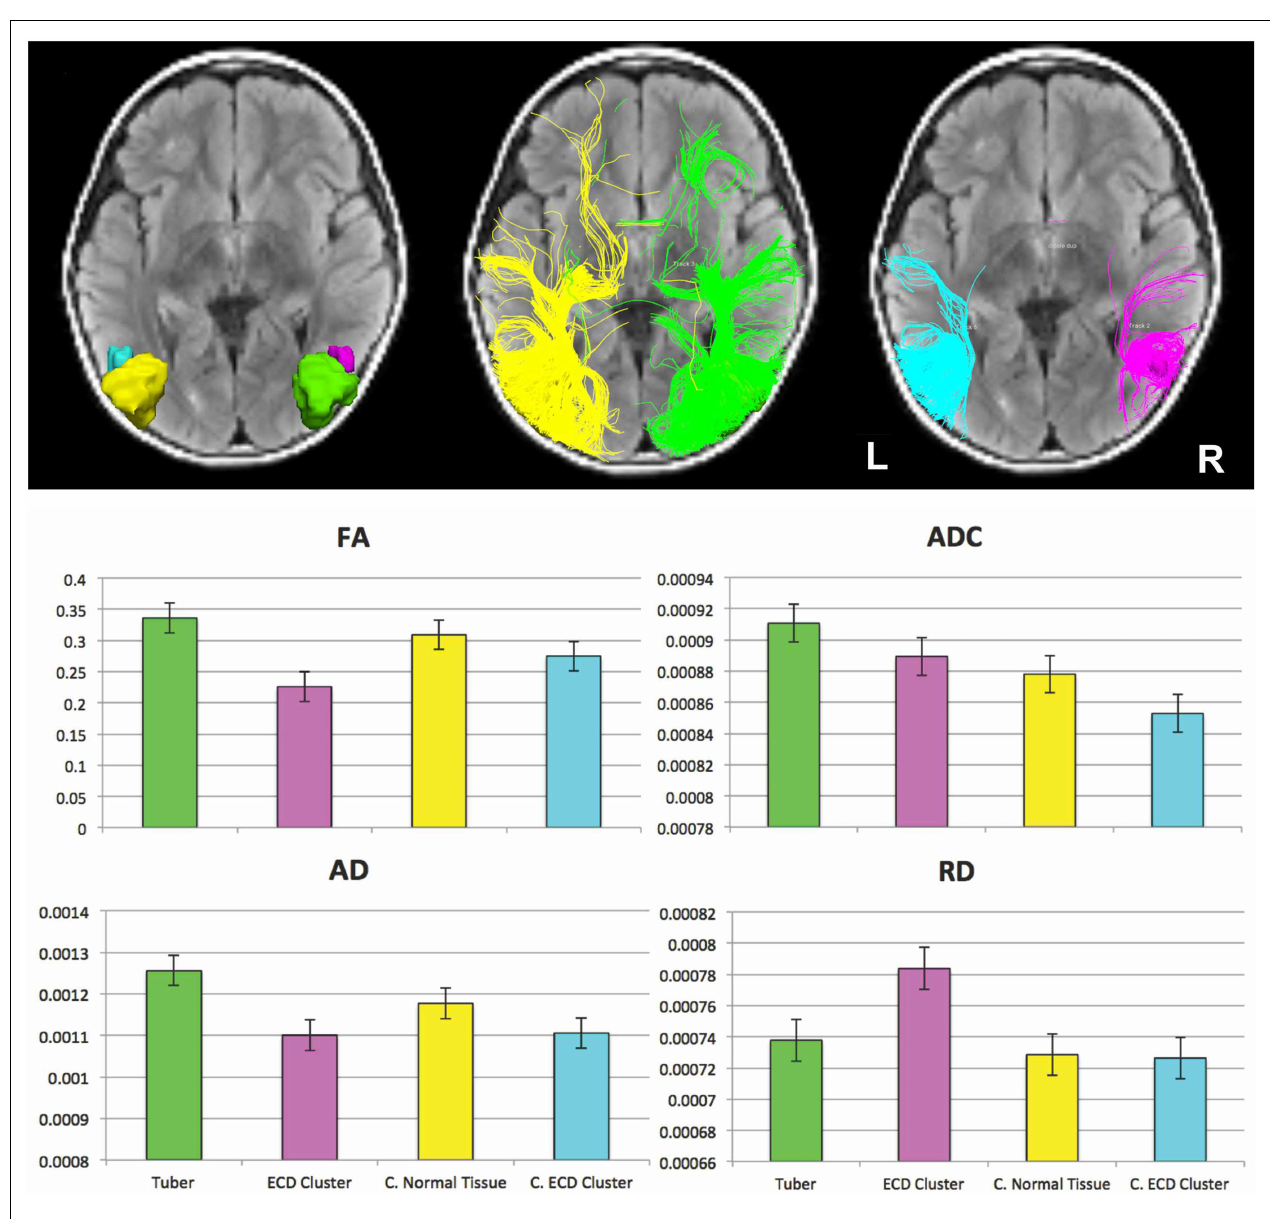
ROIs defined by the tuber (green) and the normal appearing tissue contralateral to the tuber (yellow). (Right-upper panel) Fibers passing through the ECD cluster (magenta) and the normal appearing tissue contralateral to the ECD cluster (cyan). (Lower panel) Mean ( ± SE) for the scalar values of mean FA, ADC, AD, and RD for fiber tracks passing through the large cortical tuber (green), the ECD cluster formed by the dipoles fitted at interictal spikes (magenta), the normal appearing tissue contralateral to the tuber (yellow), and at the normal appearing tissue contralateral to the ECD cluster